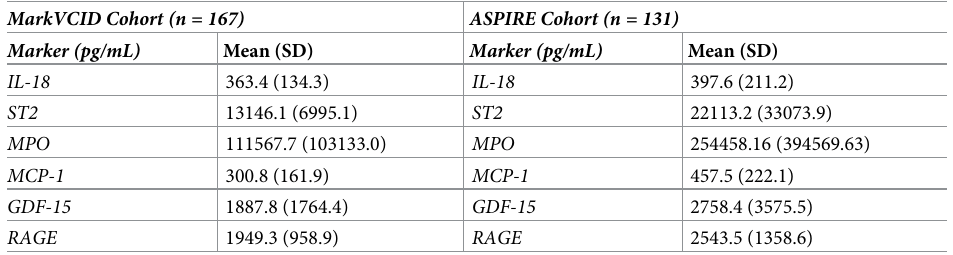
Table 2. MarkVCID and ASPIRE cohort inflammation levels.